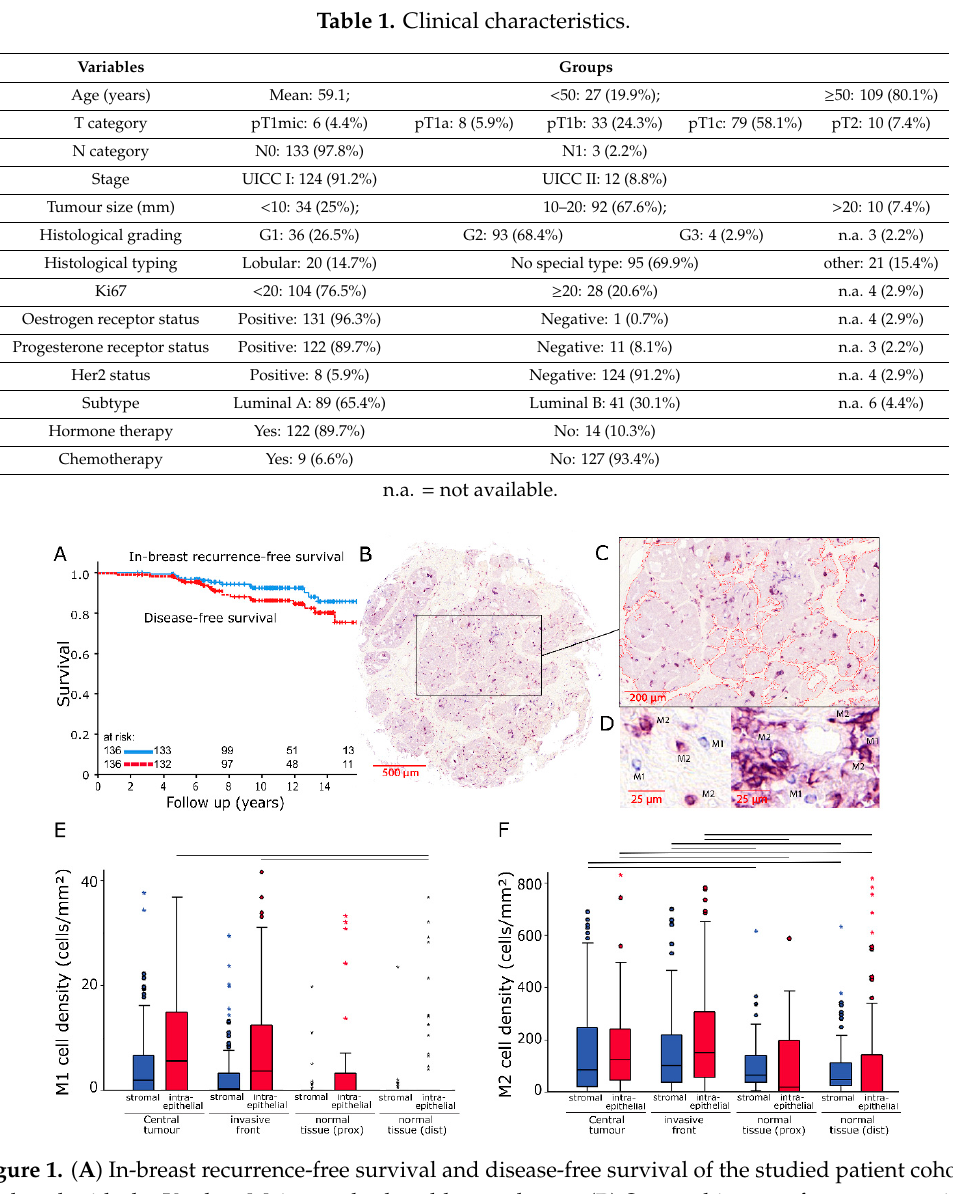
Table 1. Clinical characteristics.